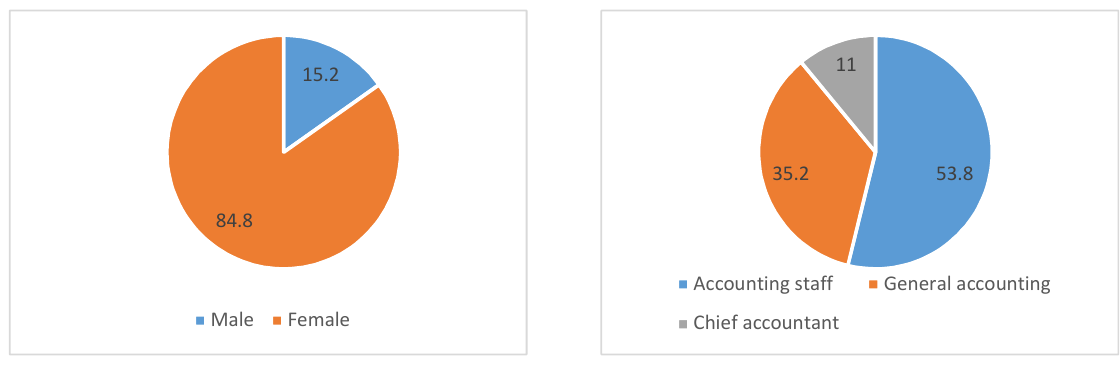
Fig. 1. Personal characteristics of the